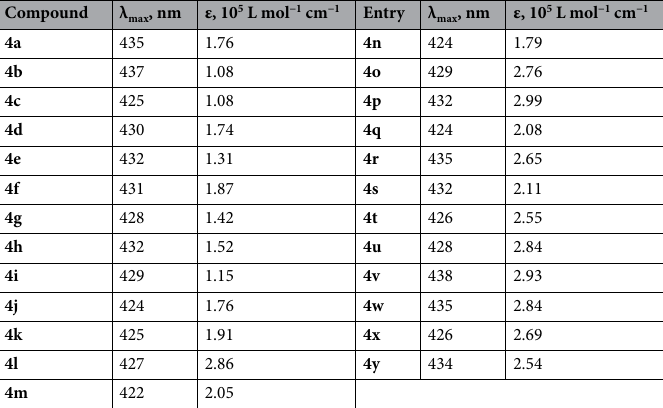
Table 5. Spectral properties of the obtained products 4a – 4y . Recorded in methanol solution.